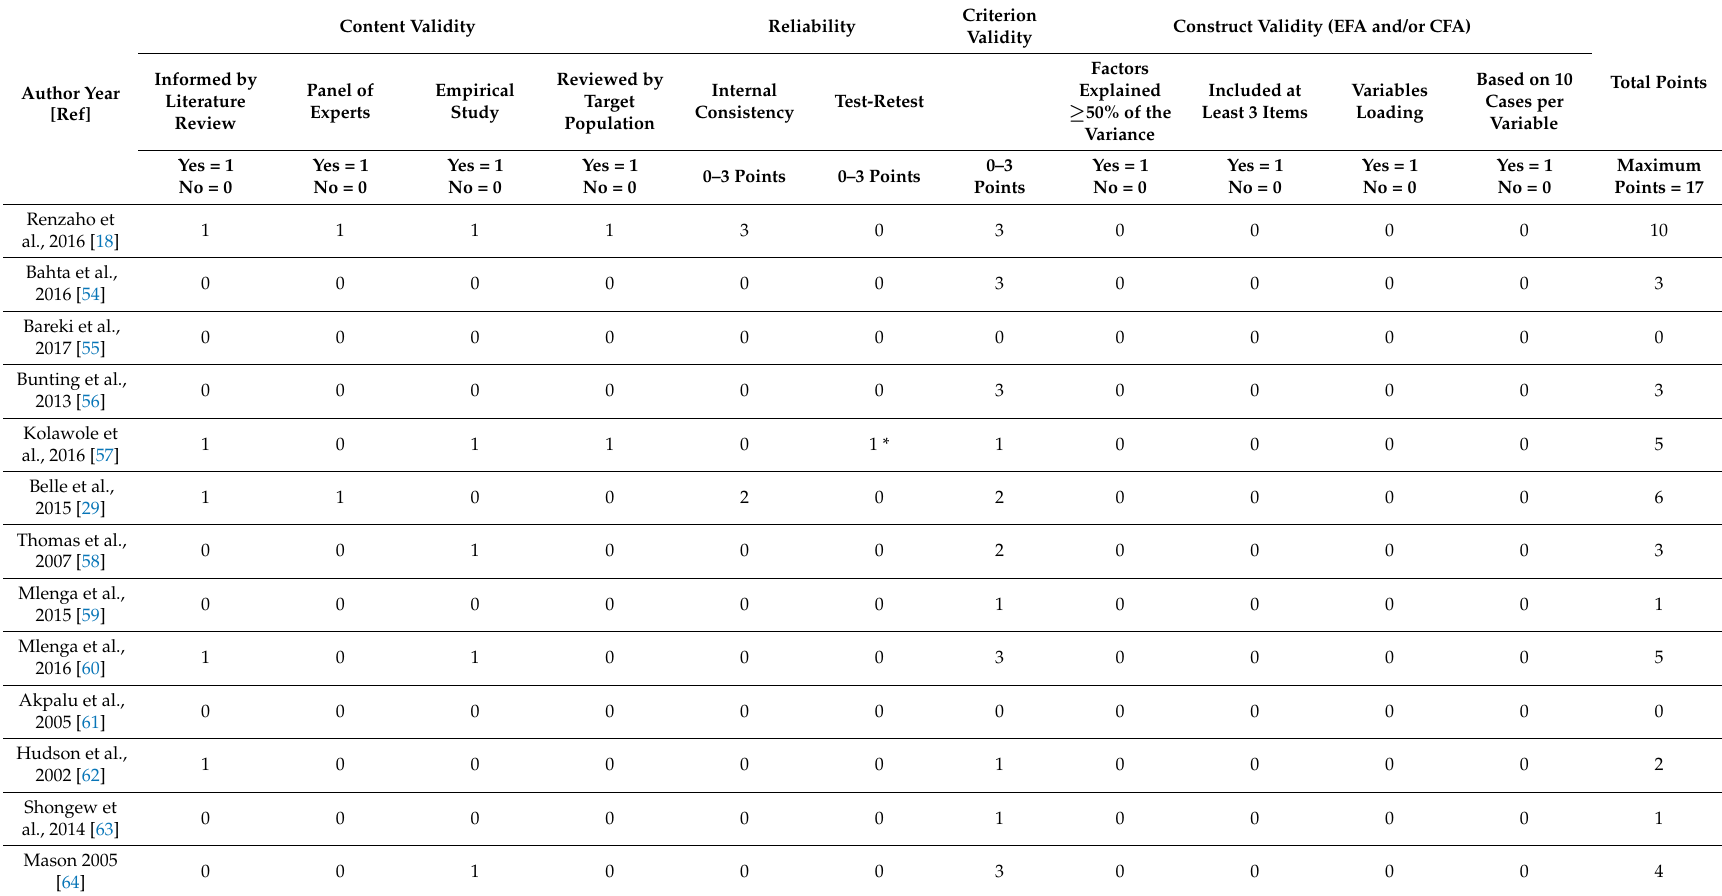
Table 2. The quality assessment of